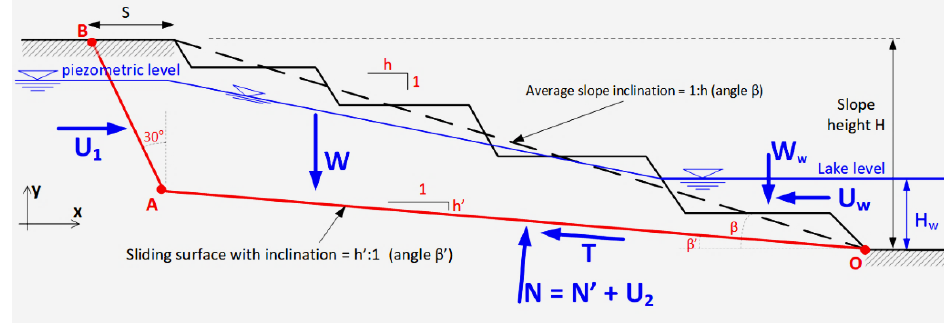
Figure 9. Geometry and forces acting on a typical sliding mass of a lignite mining slope. The sliding surface is assumed to reach the top of the slope, at distance (S) from the crest, with a planar transition (AB). It is assumed that a tension crack develops along (AB), only a water thrust (U 1 ) acts on (AB) and that (AB) has an inclination of 30 degrees to the vertical plane (the inclination of (AB) has a small effect on the stability calculations). The blue line in the figure shows the assumed piezometric level along the failure surface